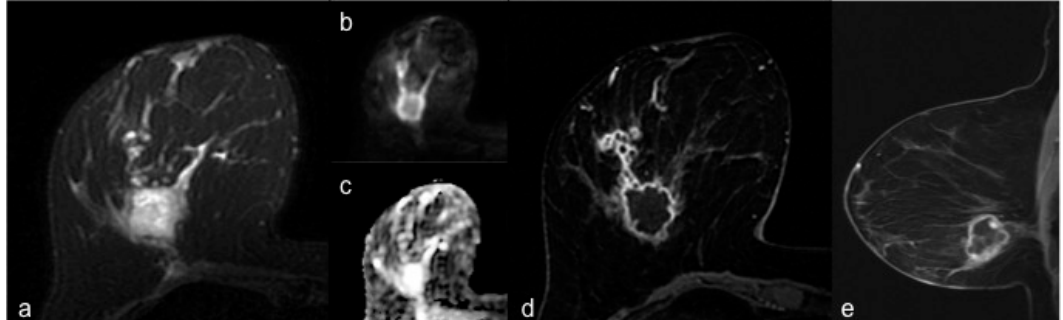
Figure 2. Breast MRI of a 53-year-old woman with TNBC of the right breast. ( a ) Axial fat-suppressed T2-weighted image shows a hyperintense round mass with irregular margins in the lower outer quadrant of the right breast. ( b ) Axial DWI image (b value = 1000 s/mm 2 ) shows peripheral high signal intensity and central hypointensity. The mass appears homogeneously hyperintense in the corresponding ADC map ( c ). ( d ) Axial and sagittal ( e ) post-contrast T1-weighted images show a corresponding irregular round mass with rim enhancement and some small foci of enhancement connected posteriorly by thin striae.